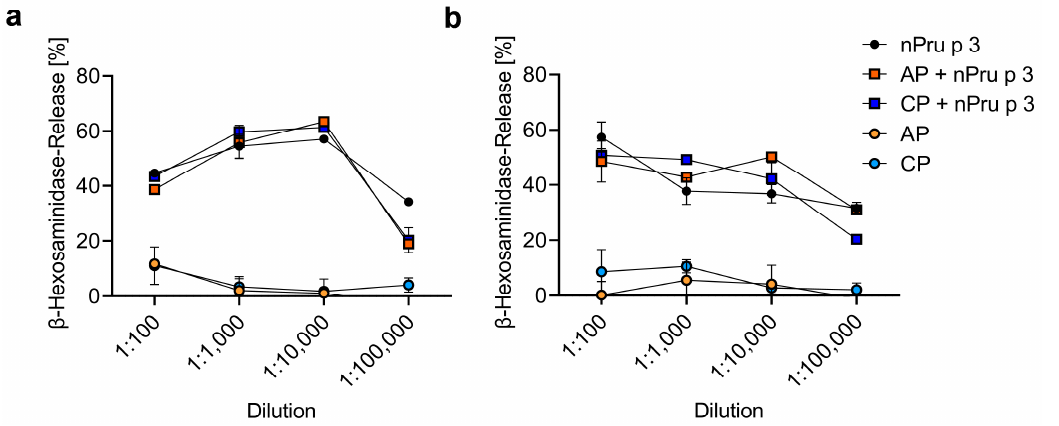
Figure 7. Mediator release assay using huRBL-30/25 cells passively sensitized with nsLTP specific IgE. Stimulation was done using enzyme-treated 5% apple-derived pectin (AP) and citrus-derived pectin (CP), either unspiked or previously spiked with nPru p 3 representing the anaphylactic ( a ) or oral allergy syndrome (OAS) ( b ) threshold added to the assay in dilution